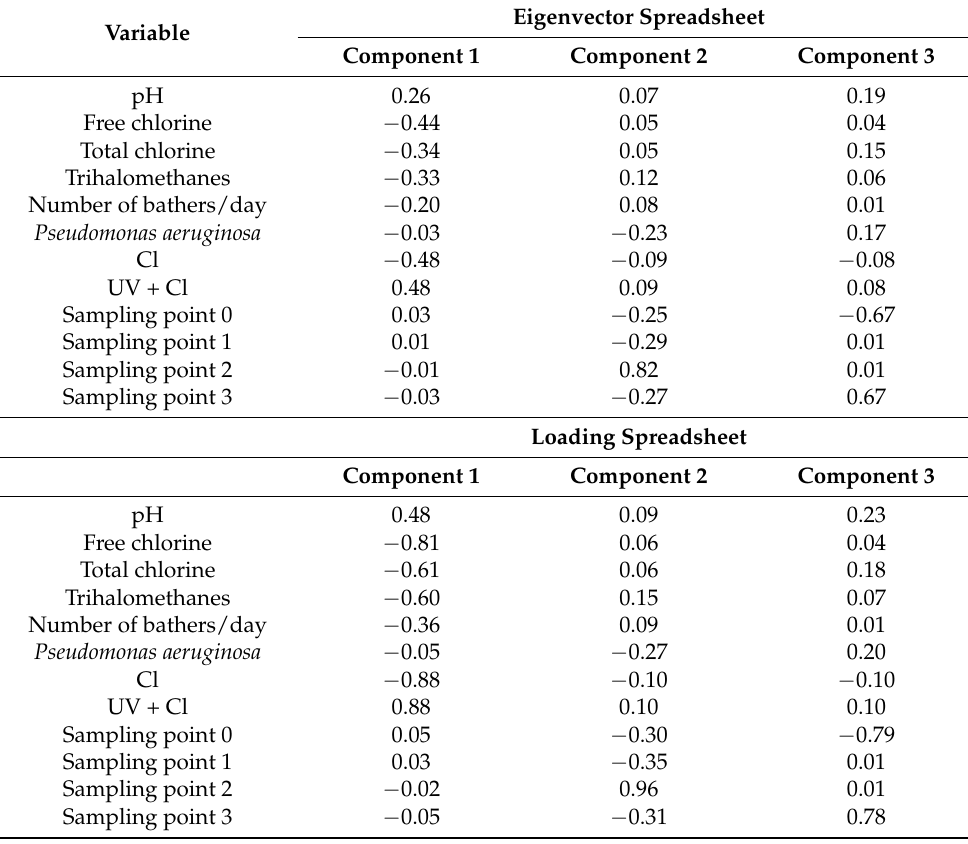
Table 4. Eigenvector and loading spreadsheet values for the chemical parameters, number of bathers per day, and Pseudomonas aeruginosa bacterial levels in the analyzed pool waters with the disinfection methods of chlorination (Cl) and chlorination with UV radiation (UV + Cl) represented by princi- pal component analysis (PCA) in the first three main components (N = 864; 216 samples × four sampling